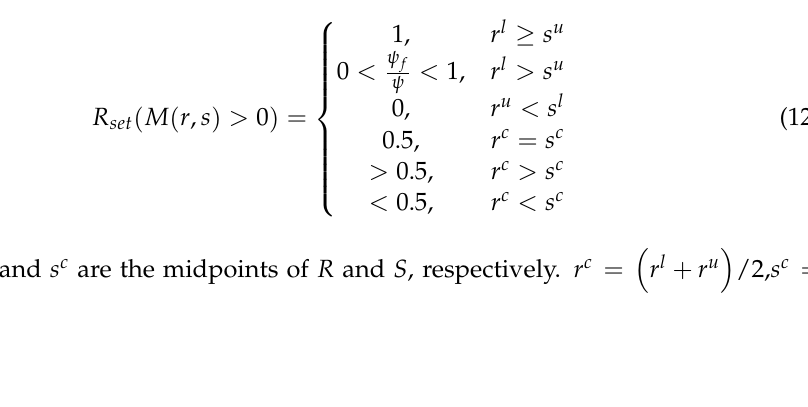
Here: ψ denotes the total area of the rectangle enclosed by the lines r = r l , r = r u ,